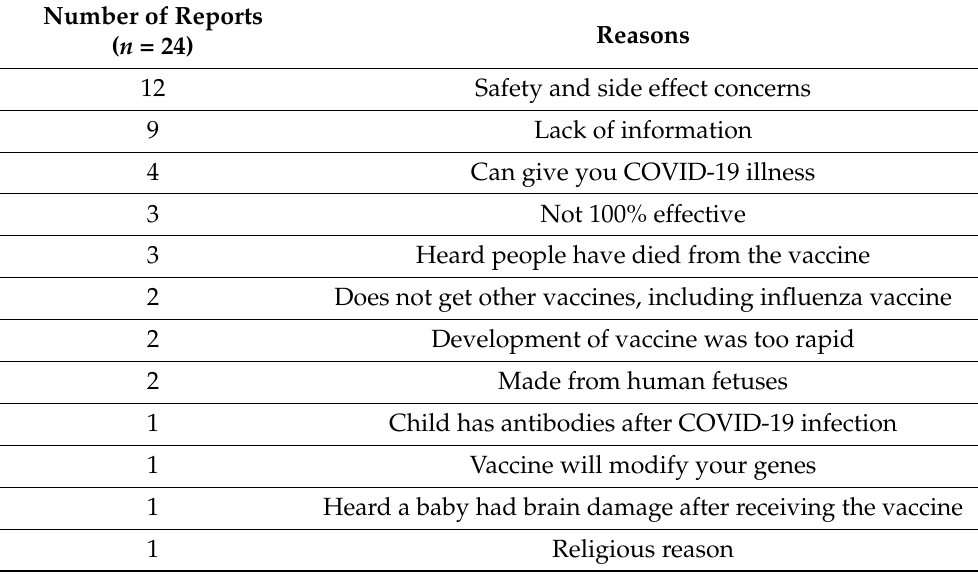
Table 3. Reasons for “no” or “maybe” in giving COVID-19 vaccine to their child on secondary